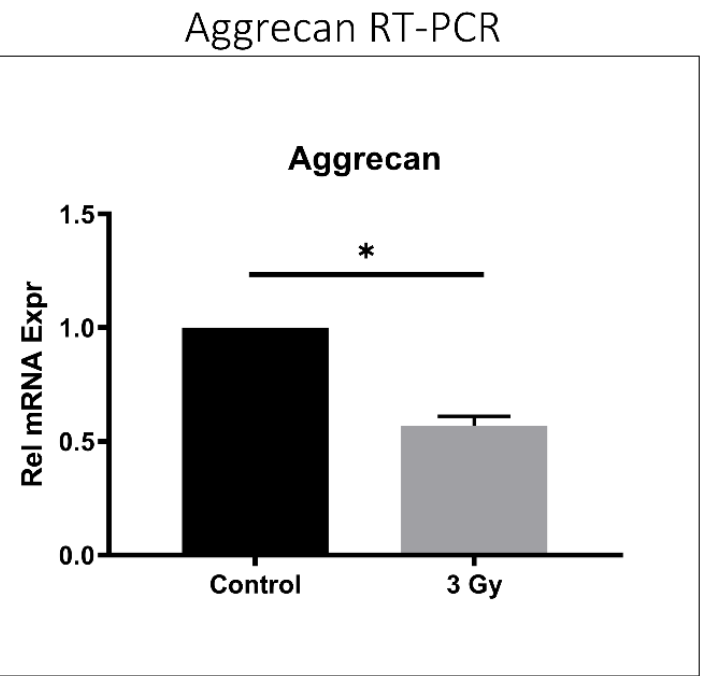
Figure 5. IR treatment reduced aggrecan gene expression in mouse intervertebral discs. RT-PCR quantification of murine aggrecan relative gene expression after the administration of 3 Gy ionizing radiation is depicted compared to control. Data shown as an average of n = 5 with one standard deviation. * p ≤ 0.05.